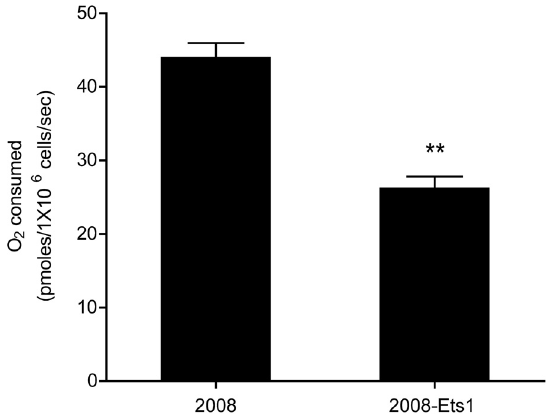
Figure 4. Effect of Ets-1 expression on oxygen consumption. Basal oxygen consumption was determined for 2008 and 2008-Ets1 ovarian cancer cells. Ets-1 expression was associated with a significant decrease in basal oxygen consumption suggesting a decreased reliance on oxidative phosphorylation in 2008-Ets1 cells. doi:10.1371/journal.pone.0013565.g004 PLoS ONE |